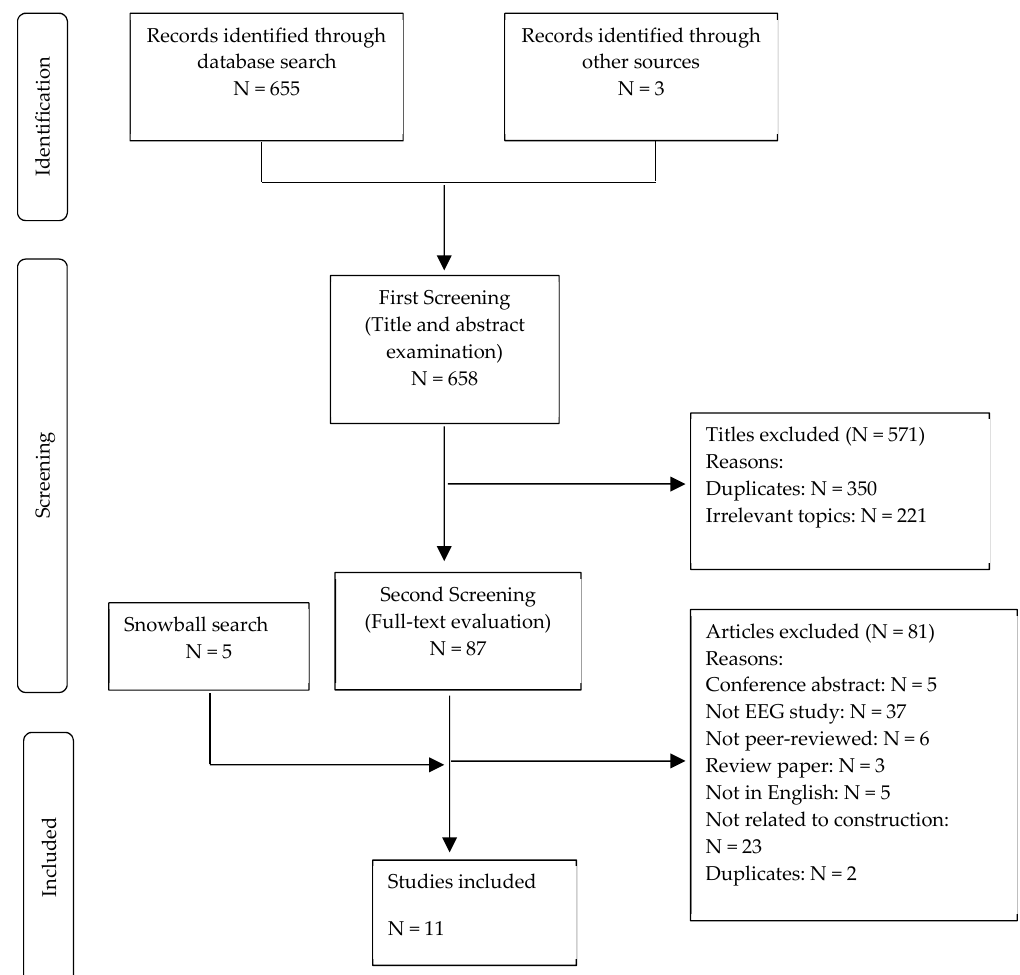
Figure 1. Flowchart of the inclusion process.